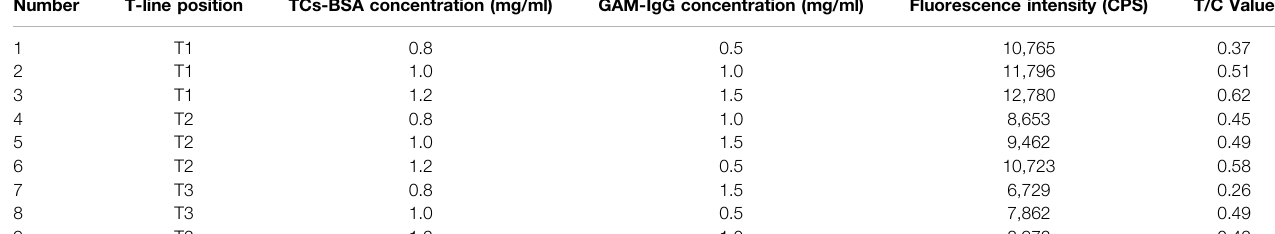
TABLE 3 | Orthogonal test to analyse the results of optimisation of L9 (3) 3 on TCs-BSA concentration, GAM-IgG concentration and paddle position. Number